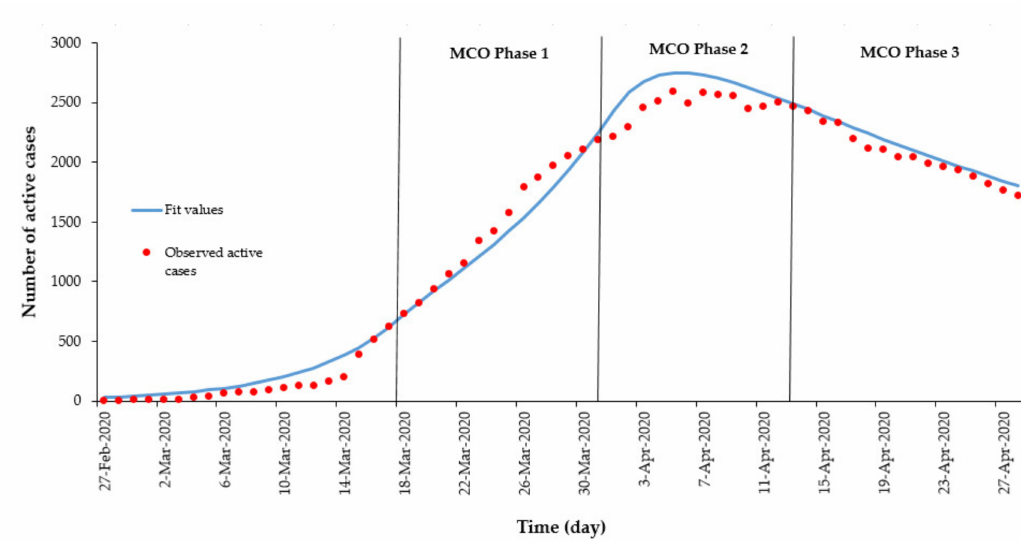
Figure 5. Observed number of COVID-19 active cases and models fit by day at di ff erent MCO